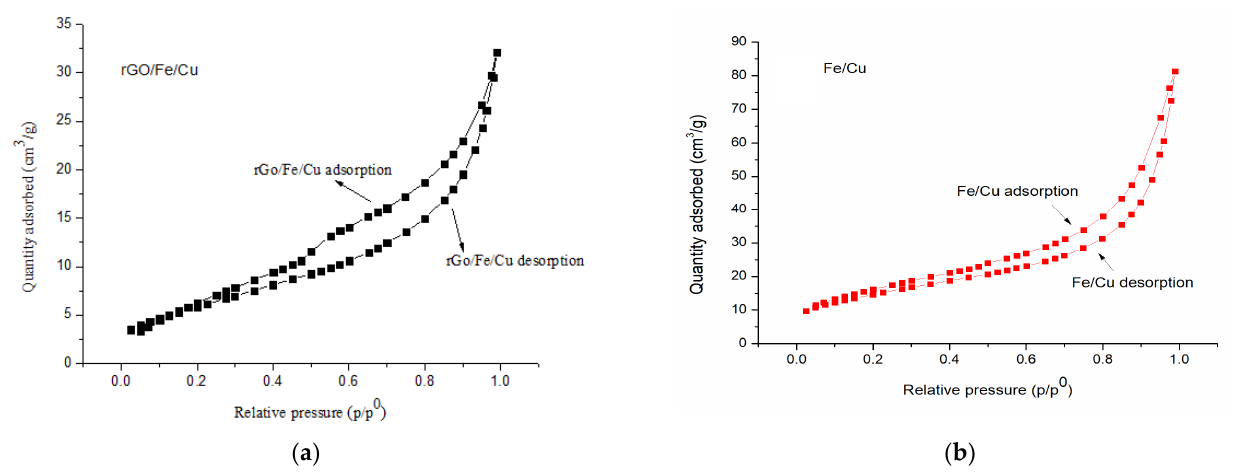
Figure 9. The adsorption and desorption isotherms of the ( a ) Fe/Cu nanoparticles and ( b ) rGO/Fe/Cu nanocompounds.